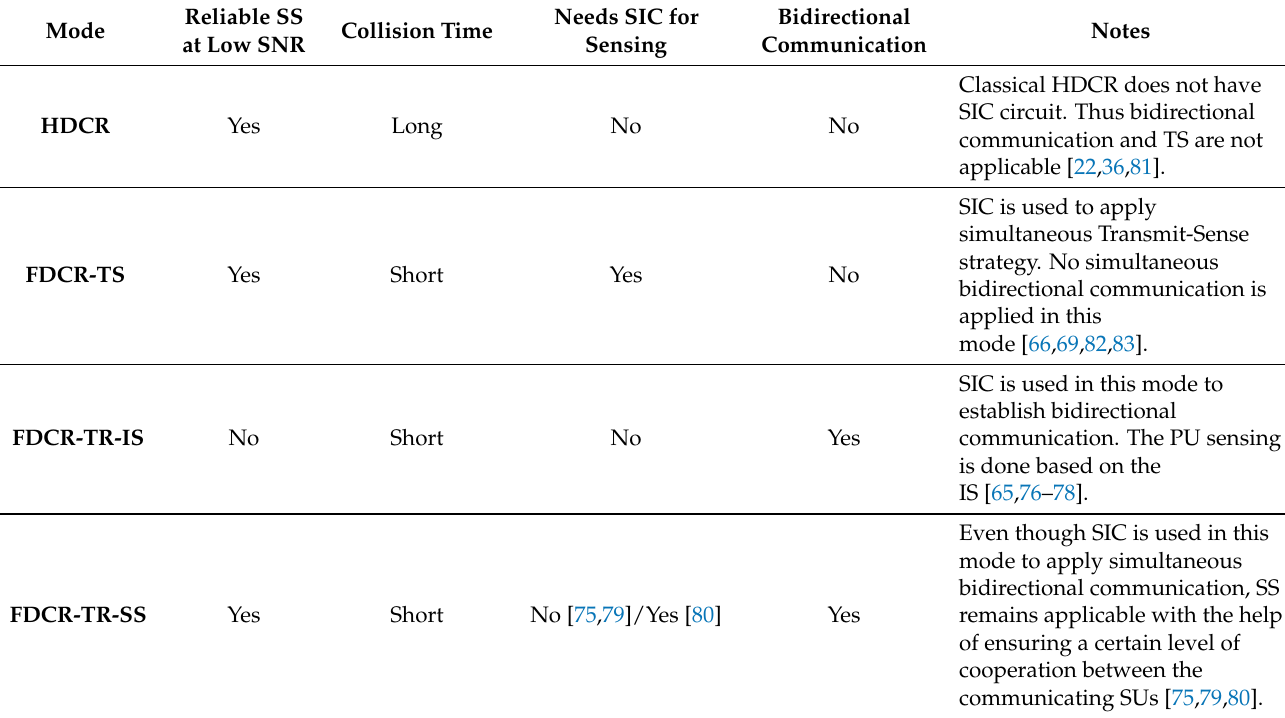
Table 3. Comparison among the CR operating modes in terms of reliability, collision time, need for SIC and the support of bidirectional